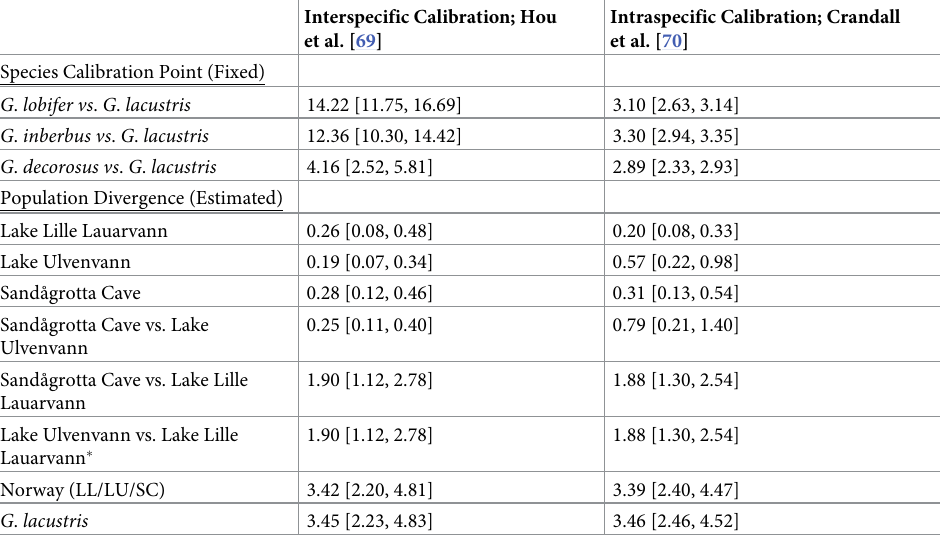
Table 6. Mean Bayesian divergence time (Ma) estimates using two different calibration schemes. The first scheme is based on calibration points derived from Hou et al. [69]. The second scheme is based on a widely used crustacean intraspecific substitution rate of 5% per million years from Crandall et al. [70]. The lower and upper 5% extreme poste- rior density values are shown in square